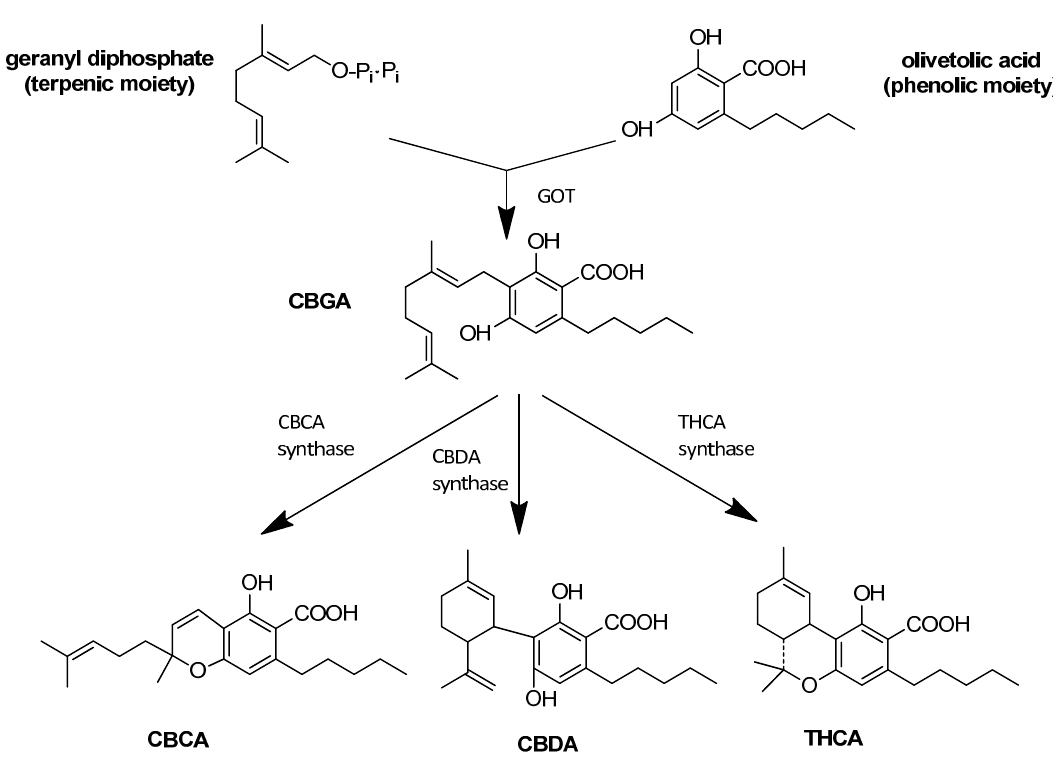
Figure 3. The biosynthesis of the main